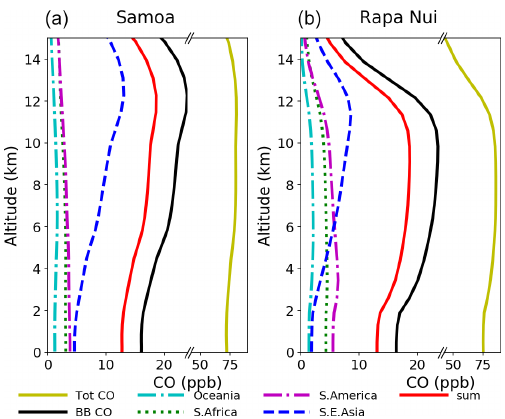
Figure 11. Vertical distribution of CO from different source regions (see legend) in Samoa (a) and Rapa Nui (b) for the high burning pe- riod (September–October–November). Total CO represents the con- tribution of all sources of CO, whereas biomass burning (BB) CO represents the sum of all biomass burning sources. The line in red (sum) indicates the sum of all individual BB contributions